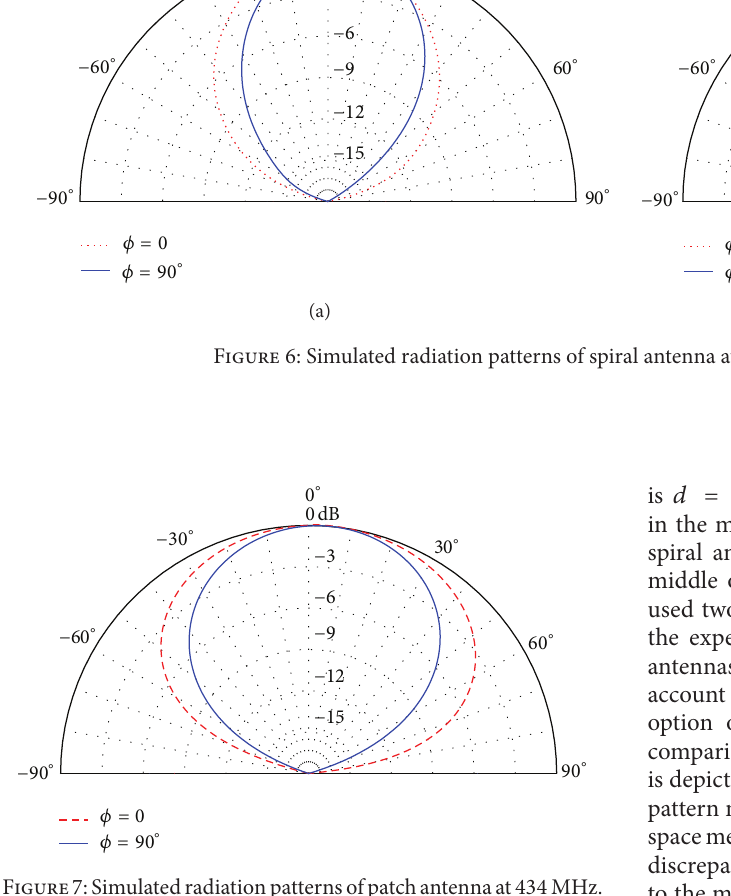
Figure7:Simulatedradiationpatternsofpatchantennaat434 MHz.